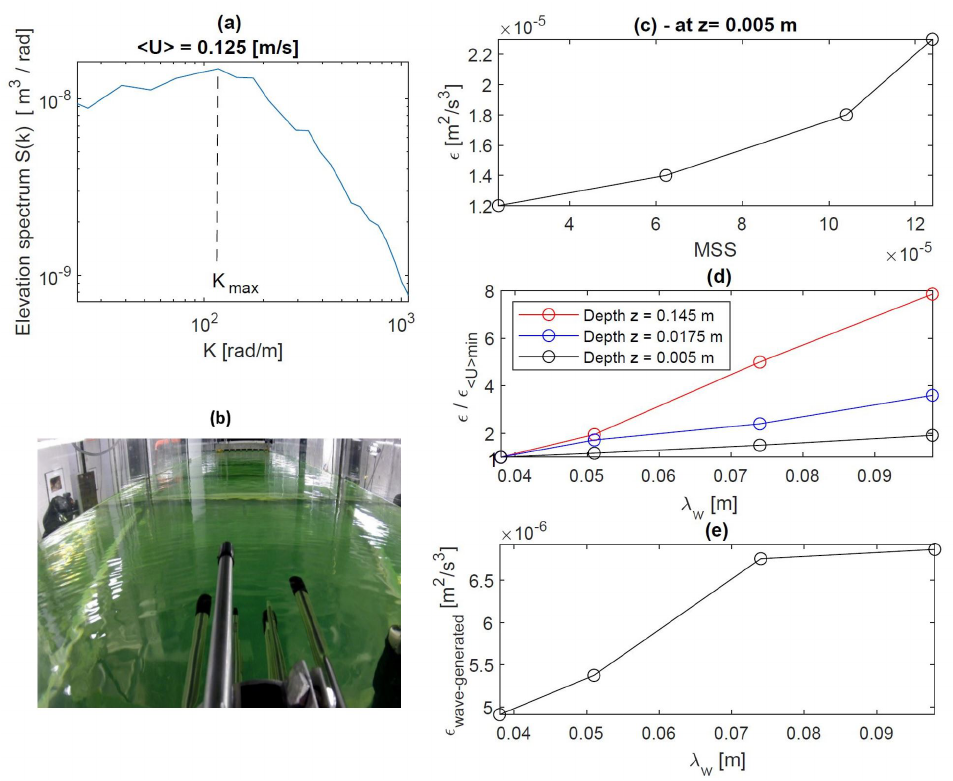
Figure 6. ( a ) The surface elevation spectrum for the mean flow velocity of < U > = 0.125 m/s is shown. The wavenumber related to the spectrum peak is shown by K max . ( b ) The non-breaking surface wave generated for < U > = 0.125 m/s while the grid is located inside the tank. ( c ) The (cid:101) change for different mean square slope (MSS) is depicted at a depth of z = 0.005 m. ( d ) The normalized (cid:101) value of different flow velocities is shown at three depths. The (cid:101) values are normalized with the (cid:101) of the lowest mean flow velocity of each depth, (cid:101) < U > min . ( e ) The subtraction of the averaged- (cid:101) within the wave-affected layer, (cid:101) 1.25 λ , from the background turbulent kinetic energy w dissipation rate, (cid:101) 0 , is considered as the wave-generated turbulent kinetic energy dissipation rate, − (cid:101) = (cid:101) wave − generated = (cid:101) 1.25 λ 0 . The data were collected at the downstream distance of x / M w